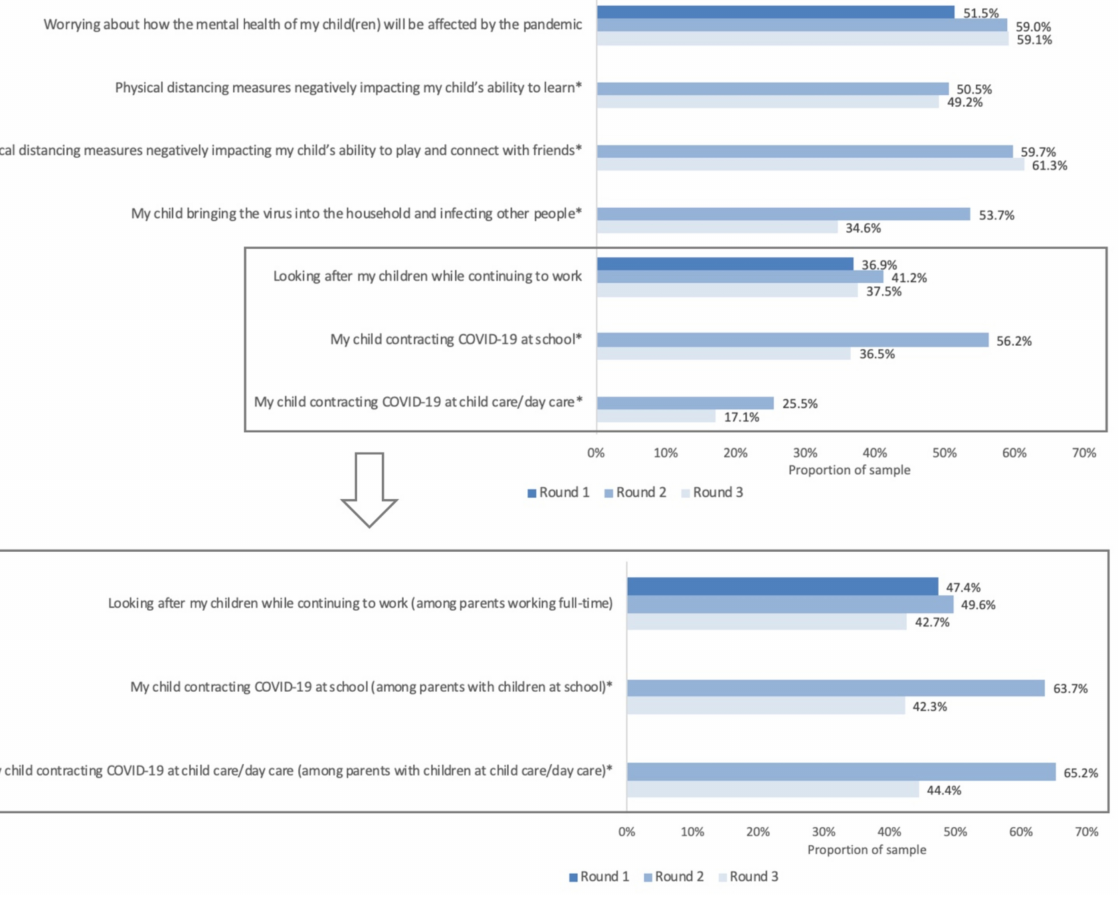
Figure 2. Parent-reported stressors in the past 2 weeks as a result of the COVID-19 pandemic, for the overall parent sample. Inset: Parent-reported stressors among subgroups of parents. * Survey item not asked in round